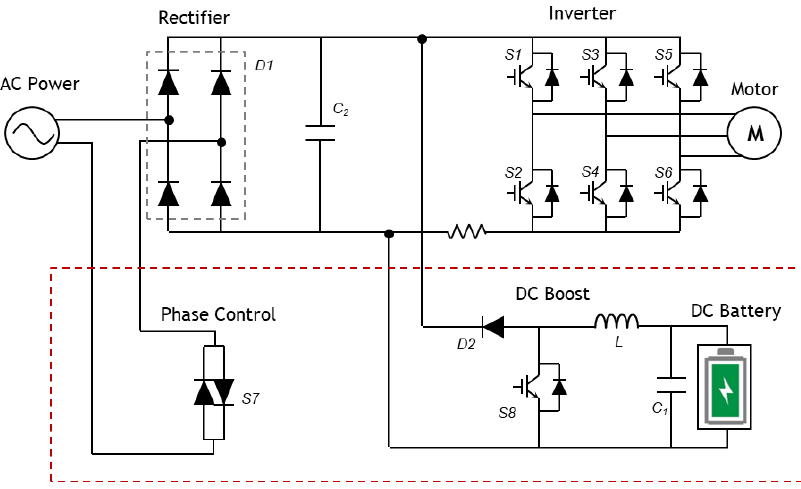
Figure 2. Circuit diagram for the ultra-high-speed sensorless drive system.